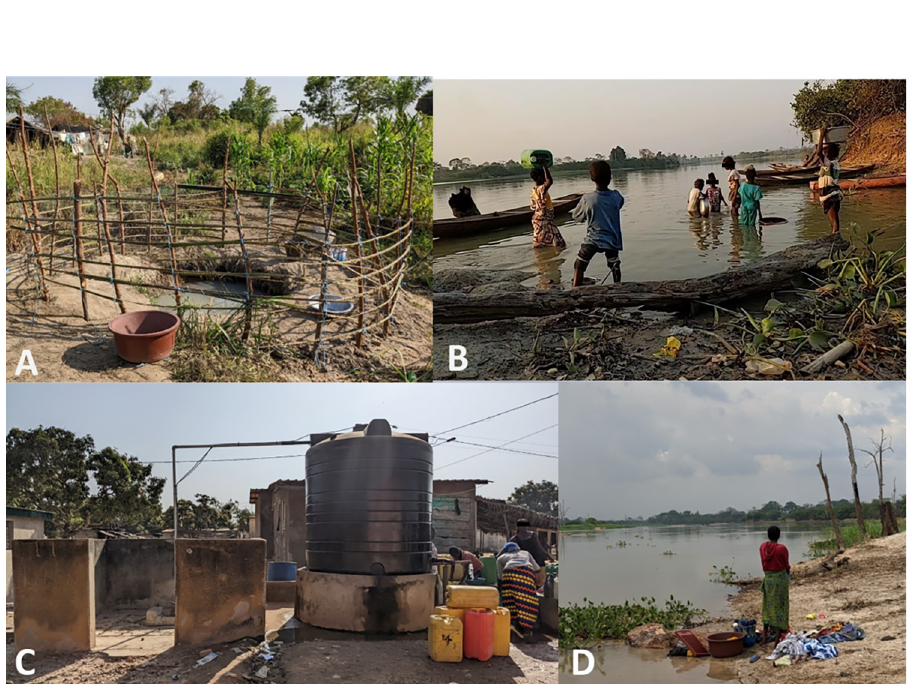
Fig 2. Type of water resources and typical human-water contacts in the study area in south-central Coˆte d’Ivoire in late 2021/early 2022. (A) dug well; (B) children fetching water at the riverbank; (C) drilled well with pump, reservoir, and tap; and (D) woman washing clothes at the